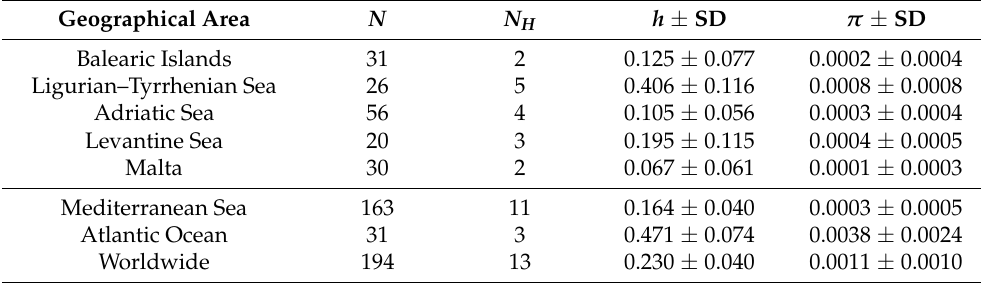
Figure 4. Haplotype network for the COI (Cytochrome C Oxidase subunit I) mitochondrial gene fragment from Raja clavata in the Mediterranean Sea. Circles in the network are proportional to haplotype frequencies and colours indicate the area where the samples are from. Perpendicular little black lines indicate mutations. Table 1. Genetic diversity estimates for the COI (Cytochrome C Oxidase subunit I) mitochondrial gene fragment from Raja clavata for the different areas of the Mediterranean, including all of this area as well as the Atlantic Ocean and worldwide populations. N : number of samples, N H : number of haplotypes, h : haplotype diversity and π : nucleotide diversity; last two with their standard deviations (SD).